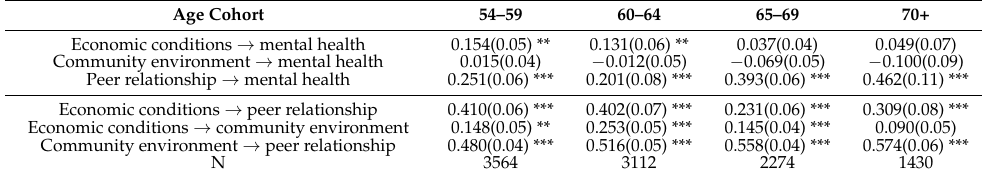
Table 4. Multi-group comparison by age